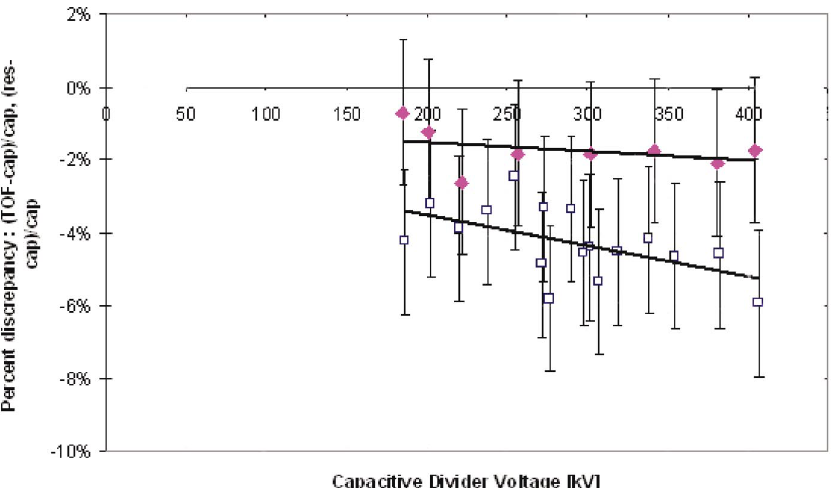
FIG. 23. (Color) The relative difference between TOF beam energy (open squares), resistive divider voltage (diamonds), and capacitive divider voltage readings (0% line) as a function of NTX Marx voltage. Both TOF and resistive divider measurements are shown as a function of capacitive divider voltage. 2% error bars are assumed for both sets of measurements. A linear fit to the data points is also shown for each set of measurements. The voltage indicated by the resistive divider lies between the capacitive divider and the TOF